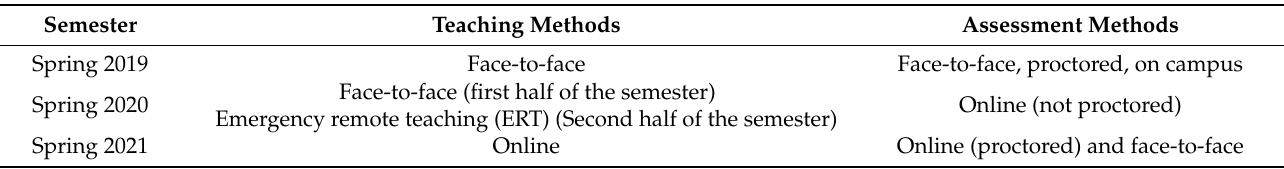
Table 1. Description of the teaching and assessment methods used during the three different